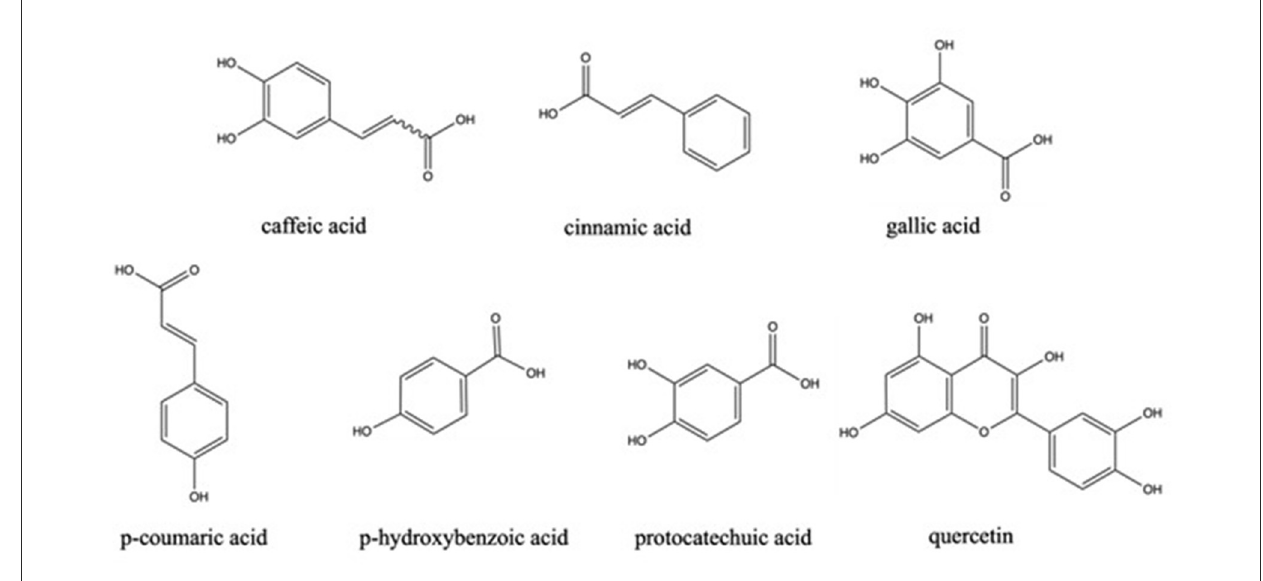
FIGURE2 Chemical structure of phenolics in